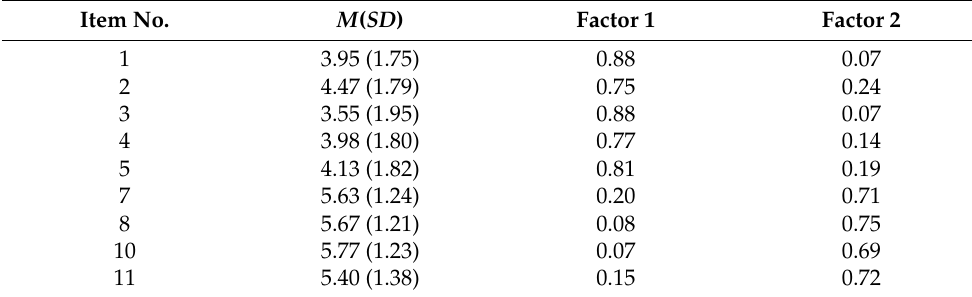
Table 1. Factor loadings of the AI Experience Questionnaire, Study 1a. Item No.